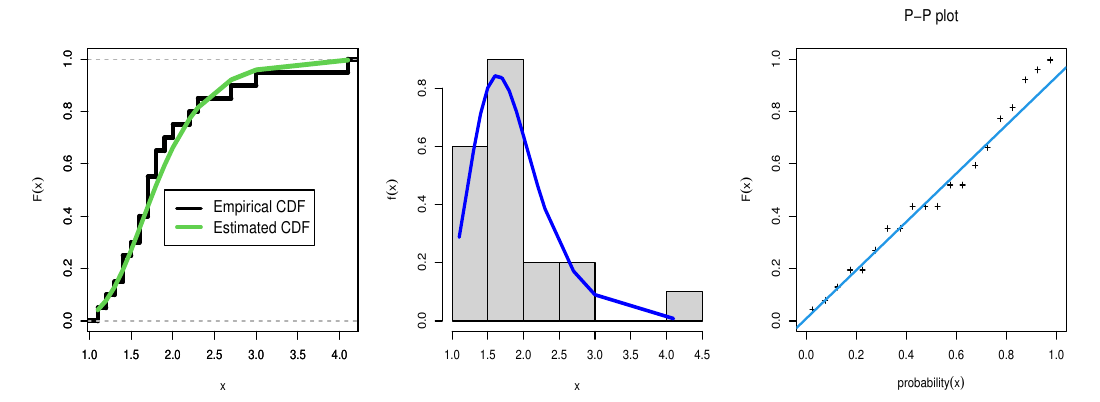
Figure 4. Estimated CDF, empirical CDF, estimated PDF with histogram, and P-P plot for the TTLLE distribution for data set